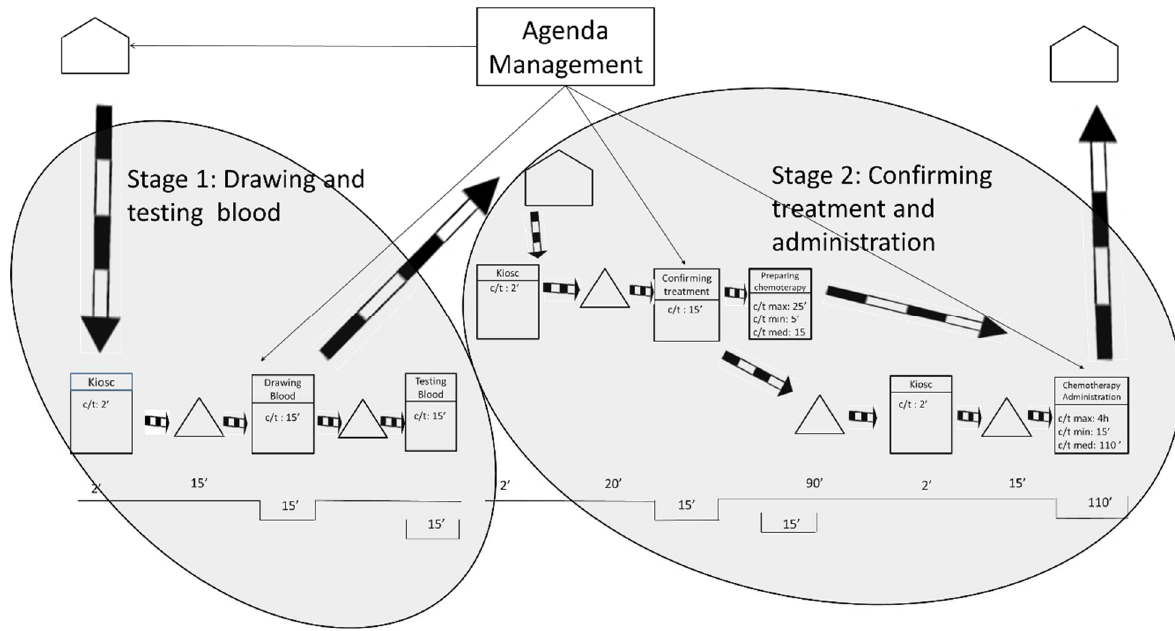
Figure 7. Future State Map